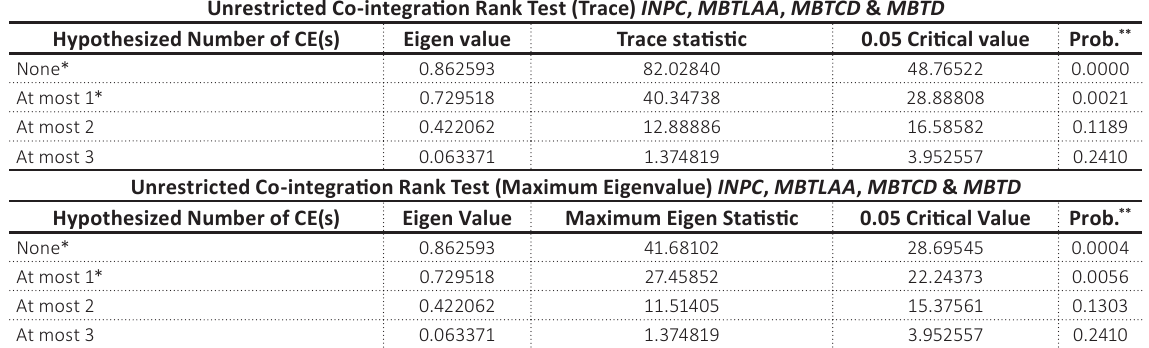
Source: Researcher’s computations.